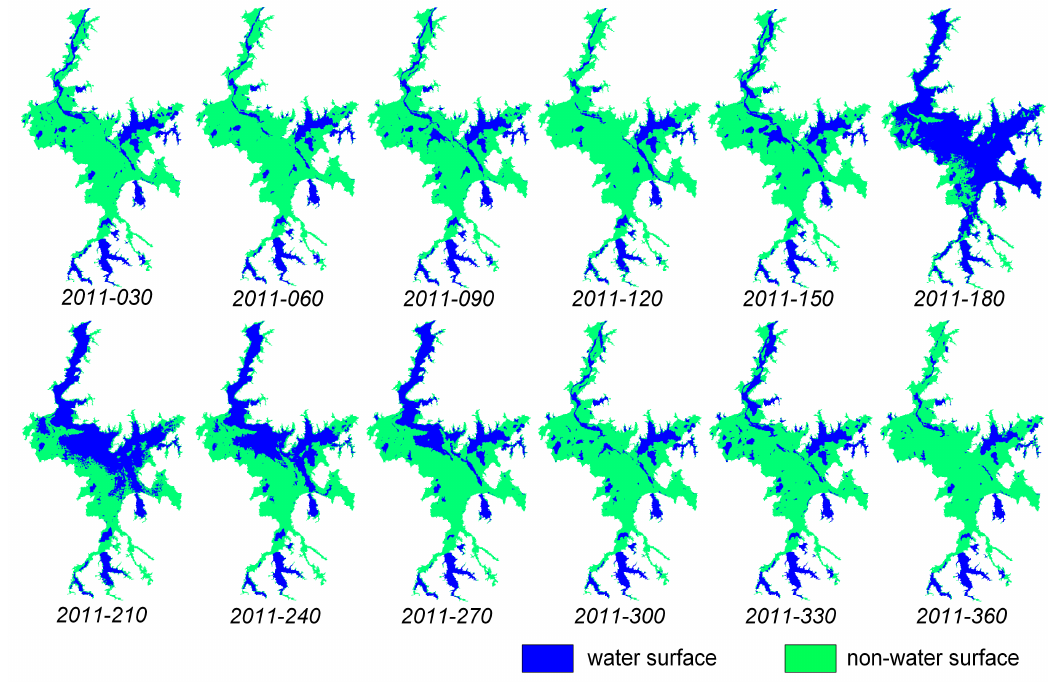
Figure 10. Monthly water surfaces for the Poyang Lake in 2011 (drought year). Lake surfaces are derived using the MinVC NDVI.